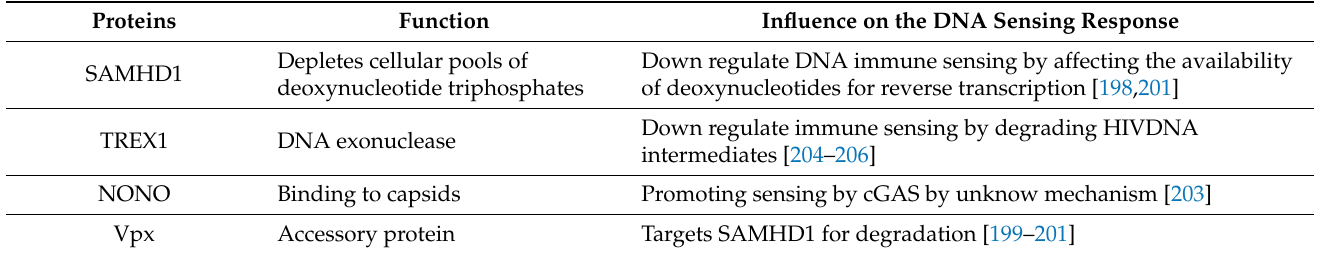
Table 5. Host and viral proteins and events that lead to the modulation of the innate immune sensing of